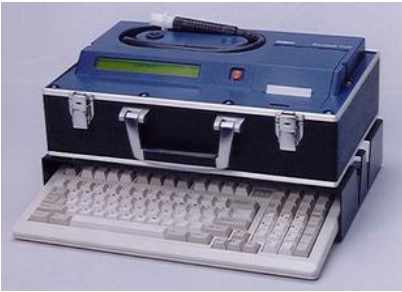
Figure 4. Alcotest 7110